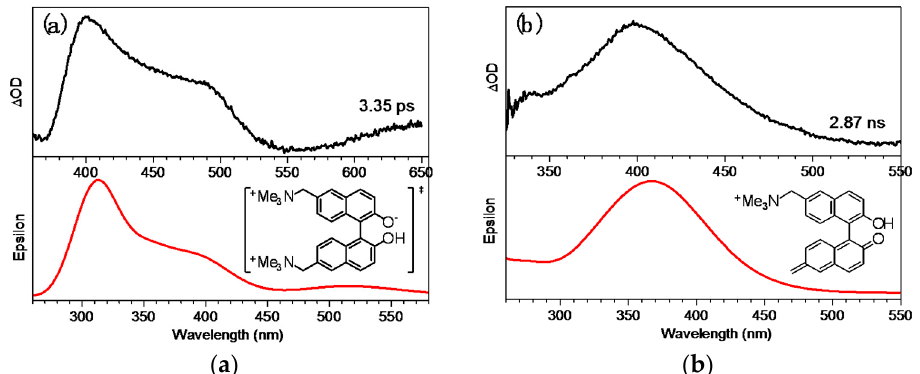
Figure 6. ( a ) The fs-TA spectrum of BQMP-b obtained after 266 nm excitation in MeCN:H 2 O (1:1, pH = 12) at 3.35 ps (top) and the computed spectrum of the singlet excited state of BQMP-b − . ( b ) The fs- TA spectra of BQMP-b obtained after 266 nm excitation in MeCN:H 2 O (1:1, pH = 12) at 2.87 ns (top) and the computed spectrum of intermediate BQM from TD-B3LYP/6-311G(d,p) calculations.